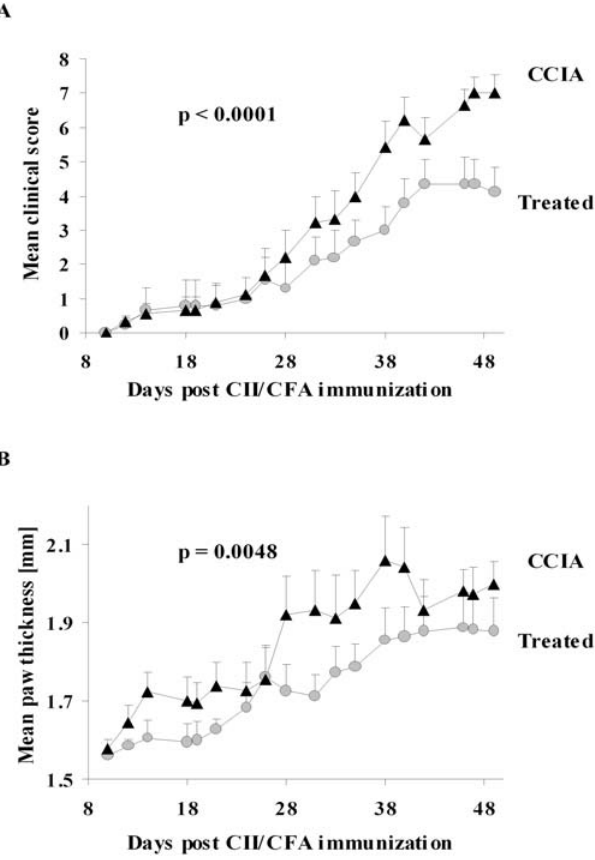
Figure 6. Lymphocytes from epicutaneously immunized mice inhibit proliferation and IFN- c production by lymphocytes from CCIA mice. Splenocytes from a sham-treated CCIA control were cocultured with splenocytes from an epicutaneously treated mouse at varying ratios (A). Total number of cells in the culture was kept constant. Cocultures were stimulated with 50 m g CII/ml and CII-specific splenocyte proliferation was assayed as in Figure 3. Black bars demonstrate the expected proliferation [cpm] in the culture, calculated by the formula: [cpm]=a f + b(1 2 f), where a=[cpm] with 100% control cells, b=[cpm] with 100% treated cells, f=fraction of control cells in the culture. The observed